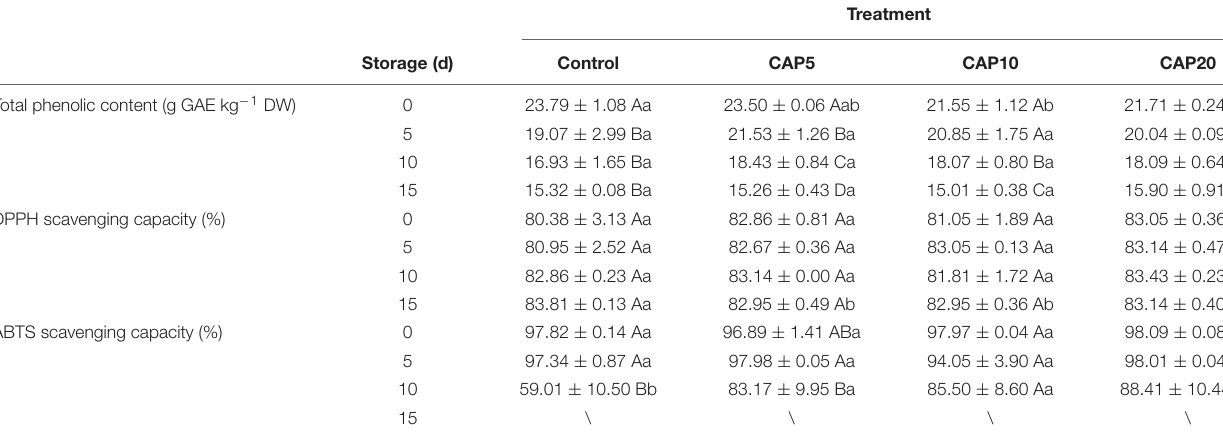
TABLE 2 | The antioxidant ability characterized by diphenyl-1-picrylhydrazyl (DPPH)and ABTS scavenging capacity, and total phenolic content (TPC) of jujubes in cold atmospheric plasma 5 (CAP5), CAP10, CAP20, and control during 15-day storage at 4 ◦ C and 90% relative humidity (RH).